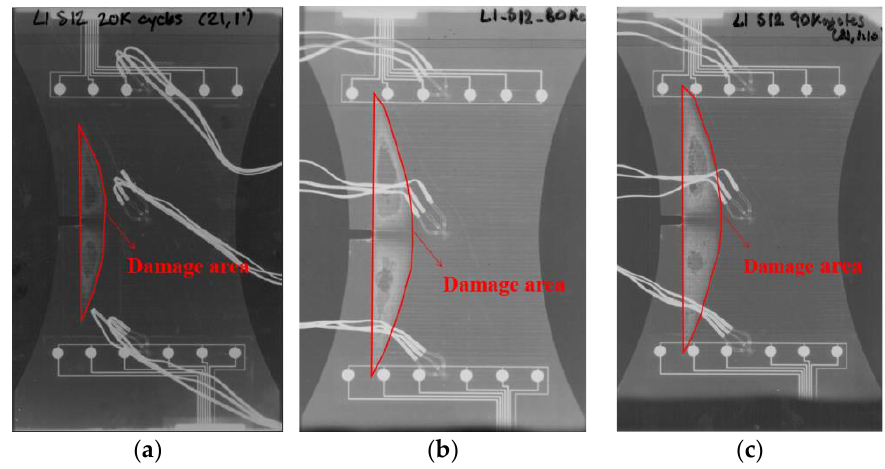
Figure 11. X-ray photographs of specimens under different number of fatigue cycles: ( a ) 20,000 fatigue cycles; ( b ) 80,000 fatigue cycles; ( c ) 90,000 fatigue cycles.